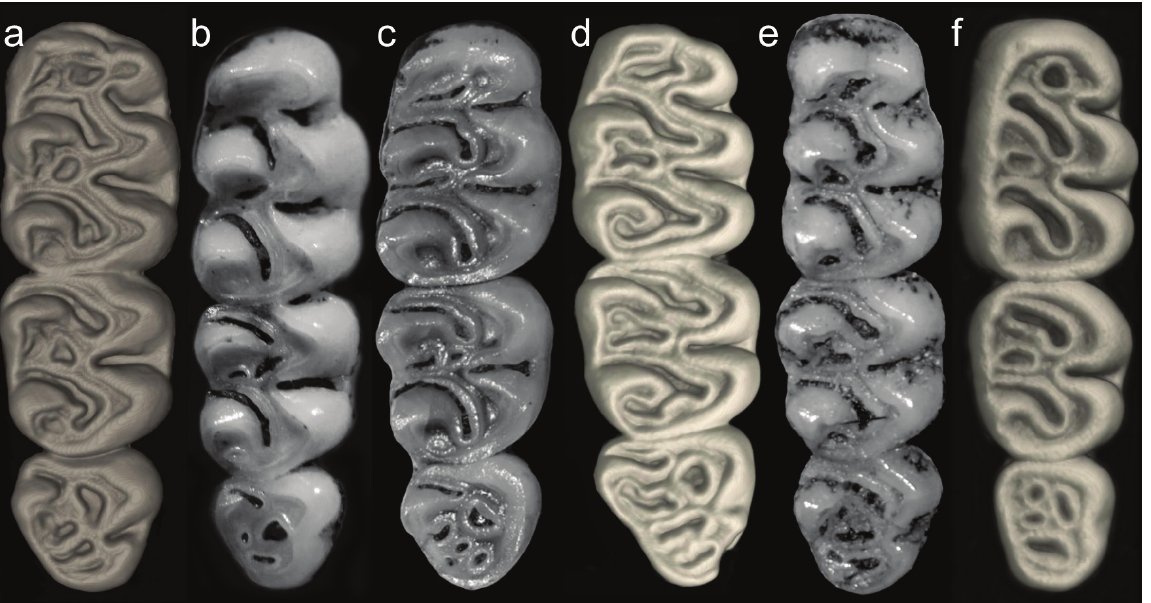
Figure 1. Occlusal views of right upper toothrows in several oryzomyines which inhabit Ecuadorian montane forests: Mindomys sp. nov. ( a MECN 5809), Euryoryzomys macconnelli ( b MUSM 27054), Nephelomys auriventer ( c MECN 3797), Tanyuromys thomasleei ( d MECN 3407), Oecomys superans ( e MECN 3371), and Sigmodontomys alfari ( f MECN 6021). Figures are not to scale to facilitate